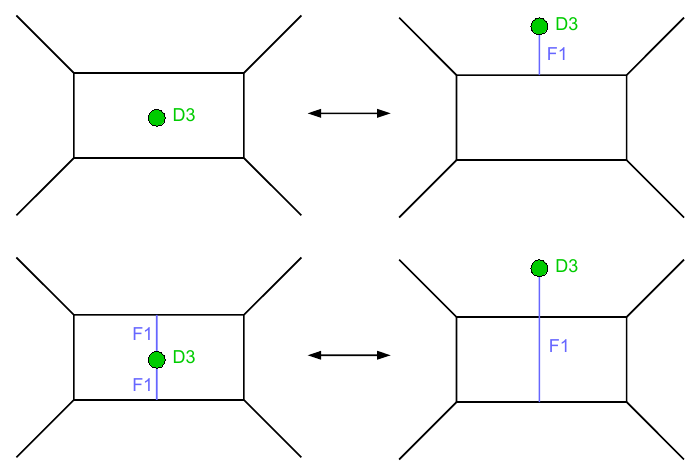
Figure 4 . The (0,0) and (1,1) string con(cid:12)gurations (on the left) are related to the two con(cid:12)gurations for the fundamental Wilson loop insertion (on the right) by Hanany-Witten